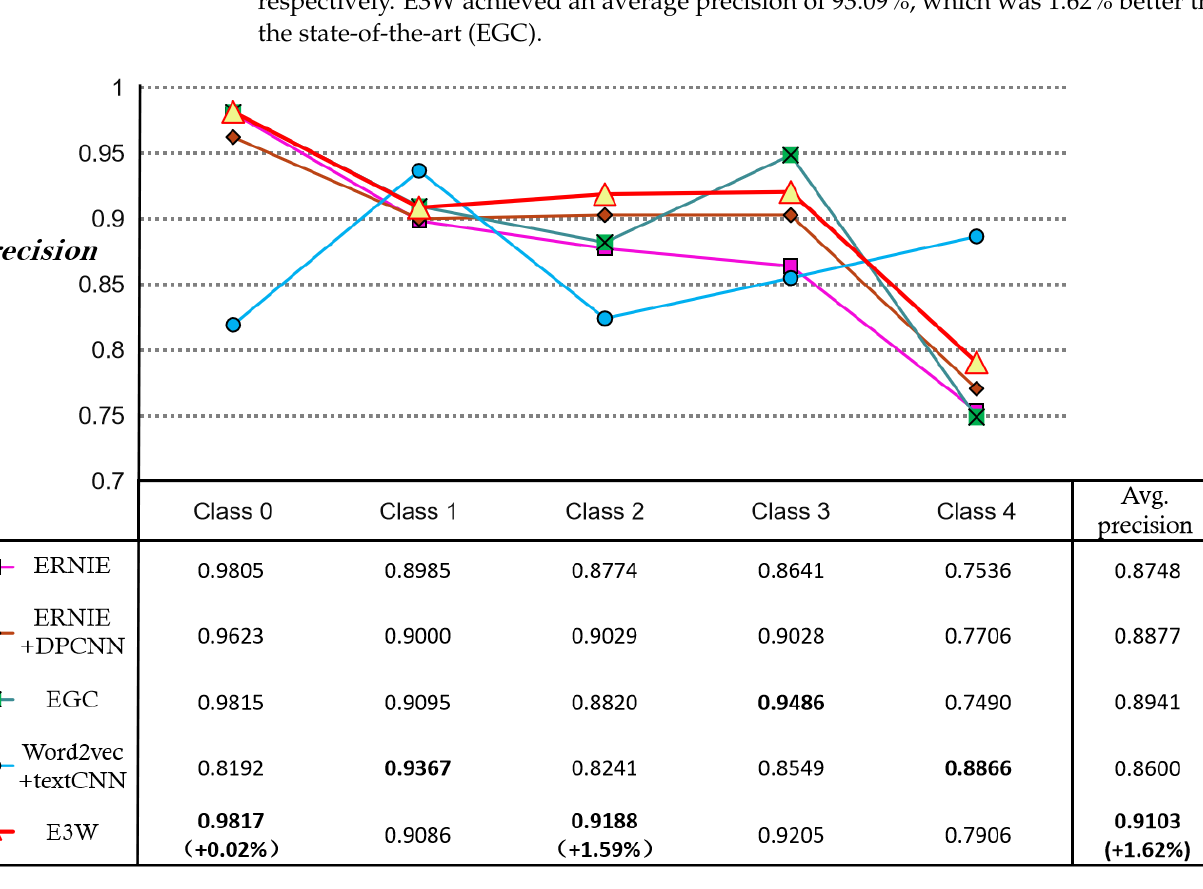
Table 6. Comparison of average accuracy for E3W and the four sub-models, with the best experi- mental results in bold and the number in brackets representing the comparison of the current model with the previous best model.